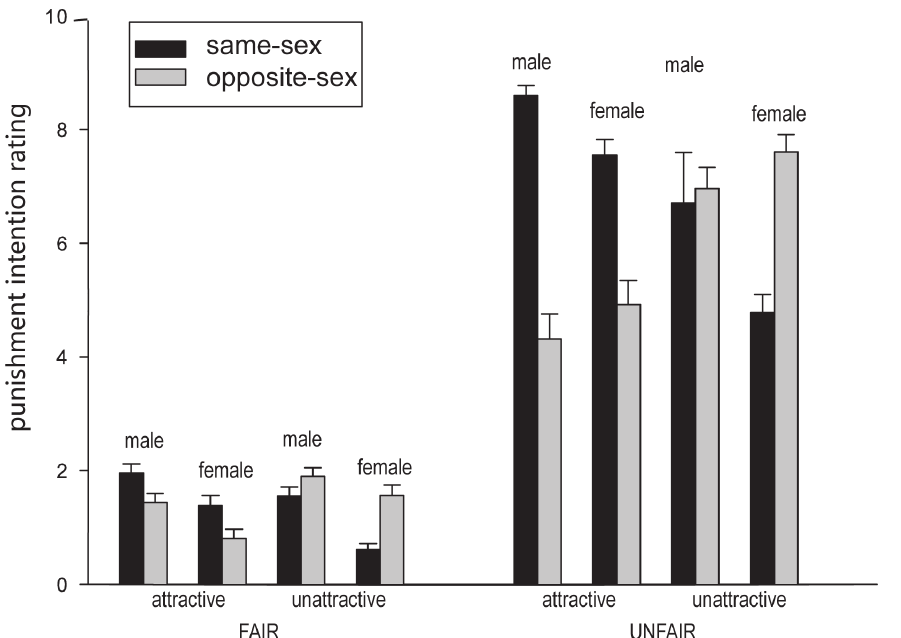
Figure 1. Mean scores for participants’ intention to punish proposers as a function of the fairness (reasonableness) of offer, proposers’ physical attractiveness and their biological sex. Same-sex = the proposer and the participant were of the same sex; opposite-sex = the proposer and the participant were of different sexes; Male = male participants; Female = female participants; Fair = the recipient received 50 or 40 yuan while the proposer received 50 or 60 yuan; Unfair = the recipient received 10 or 20 yuan while the proposer received 90 or 80 yuan. Error bars represent standard errors.